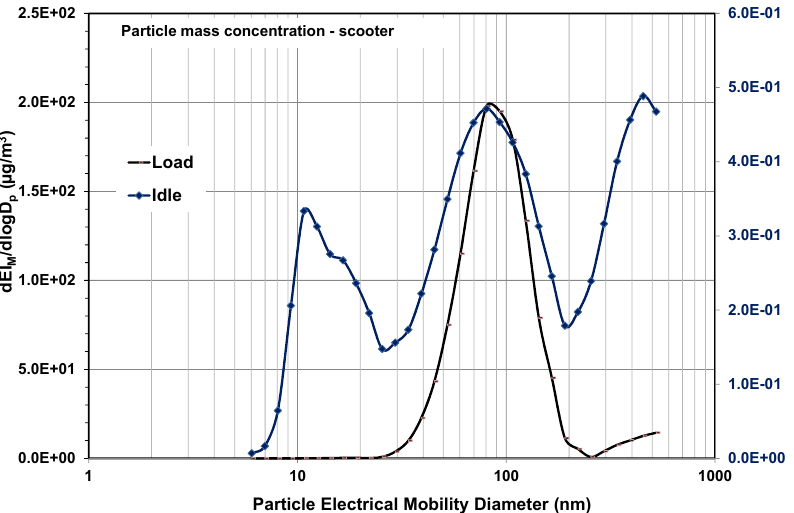
Figure 5. Particle mass distribution obtained for scooter.